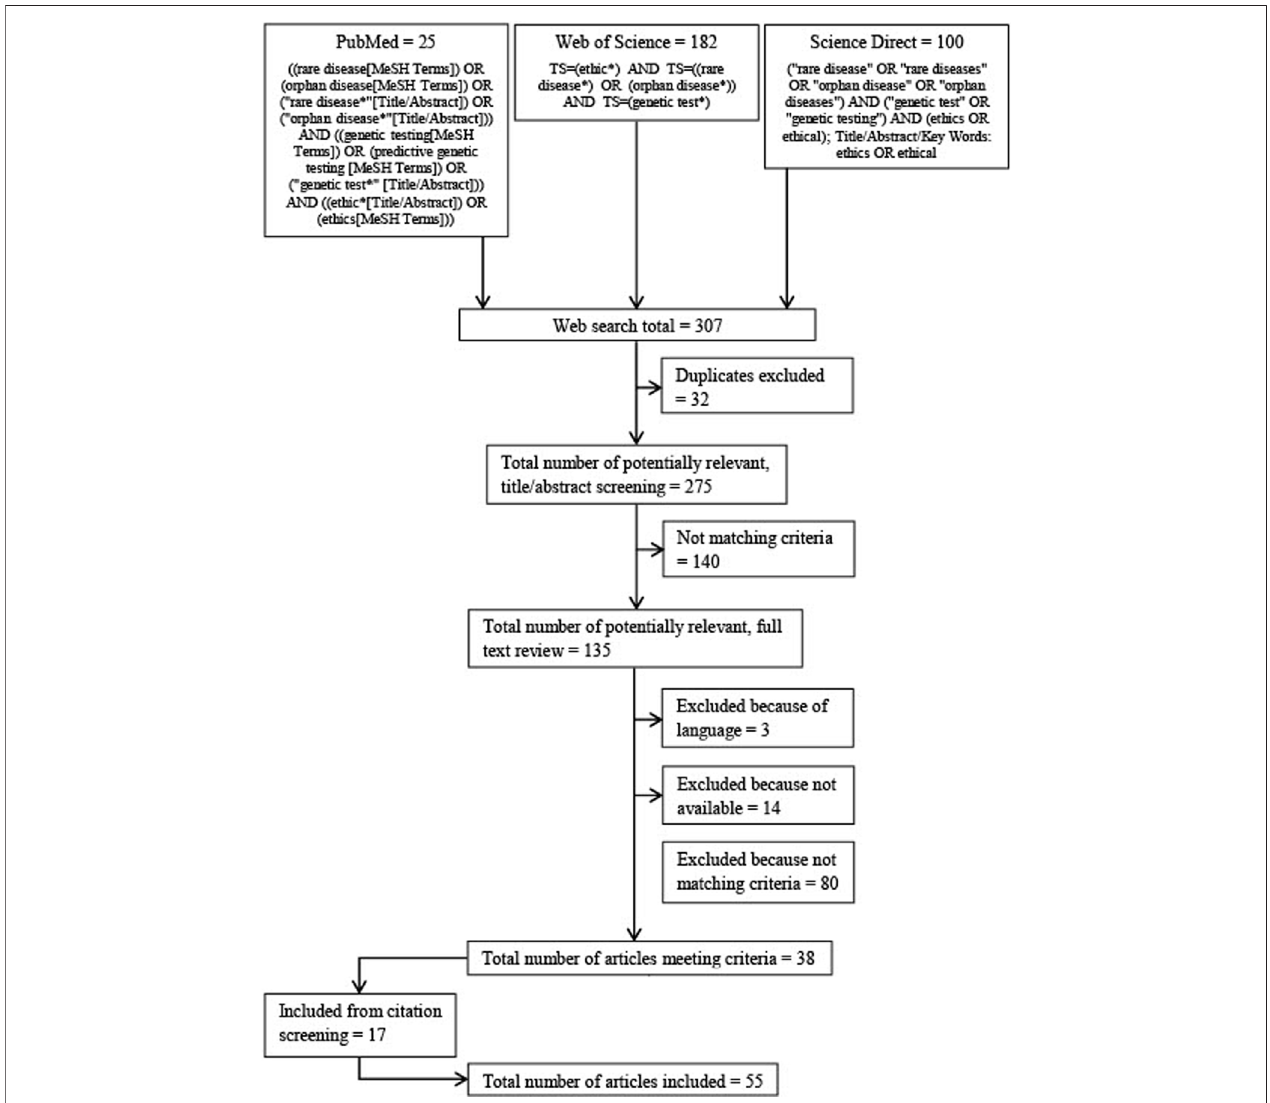
FIGURE 1 | Flow diagram and search